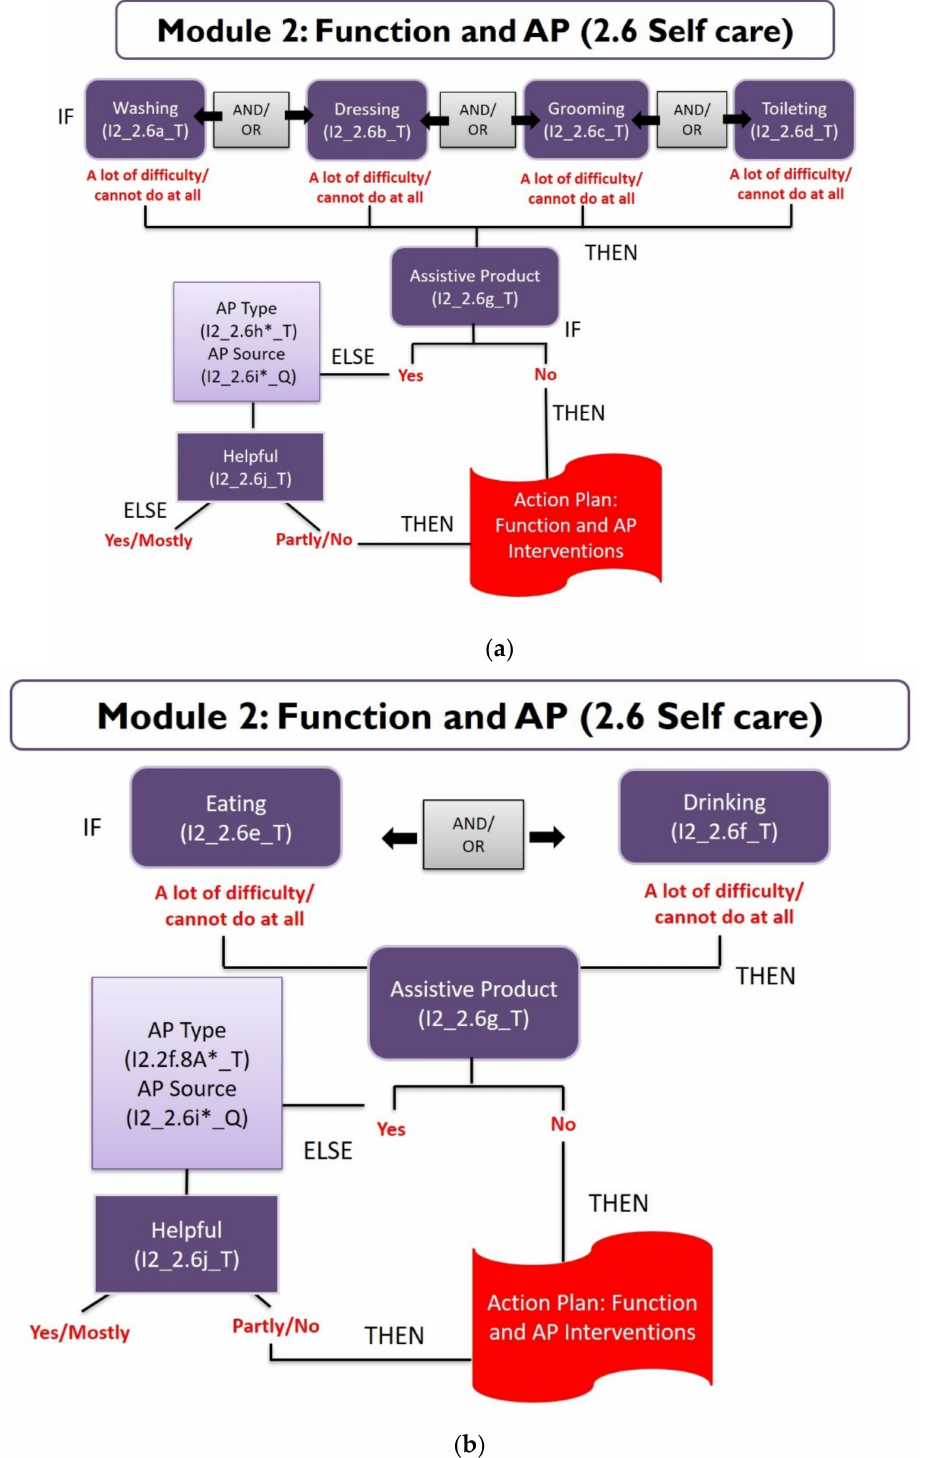
Figure 3. ( a ). Decision tree for washing, dressing, grooming and toileting in the self-care domain. ( b ). Decision tree for eating and drinking in the self-care